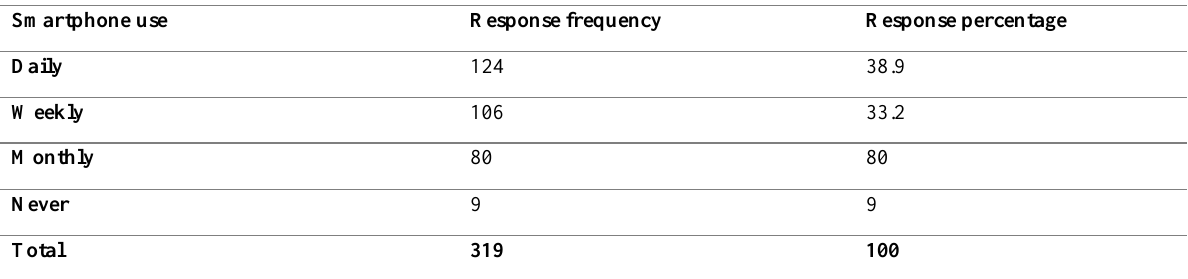
Table 1: Frequency of Smartphone